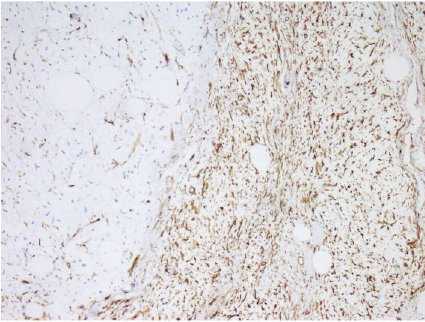
Figure 5: CD34-positive spindle cells (H&E ×